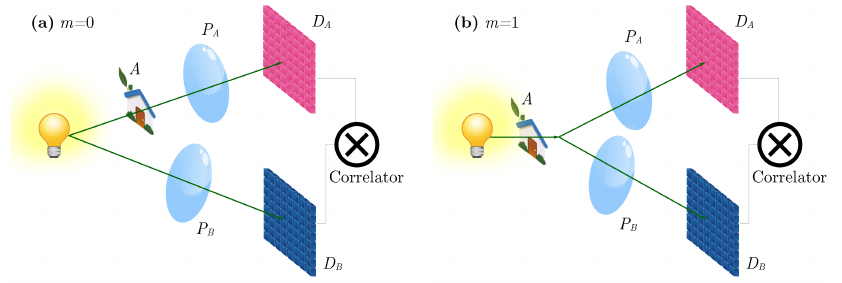
Figure 1. Comparison between different CPI protocols. ( a ) The source can emit either entangled photons or chaotic light. Light from the source is split into two paths: in one arm, light illuminates the object, passes through a lens and is detected by detector D a ; in the second arm, light propagates freely toward a lens and is collected by sensor D b . in Equation (4). ( b ) The source emits chaotic light, which illuminates the object, and is then split into two paths; each beam then passes through a lens and is collected by a detector. In both panels, A indicates the aperture function of the object, P A , B the pupil functions of the lenses, D A and D B are high-resolution detectors, ⊗ indicates that correlations are measured between the two detectors D A and D B